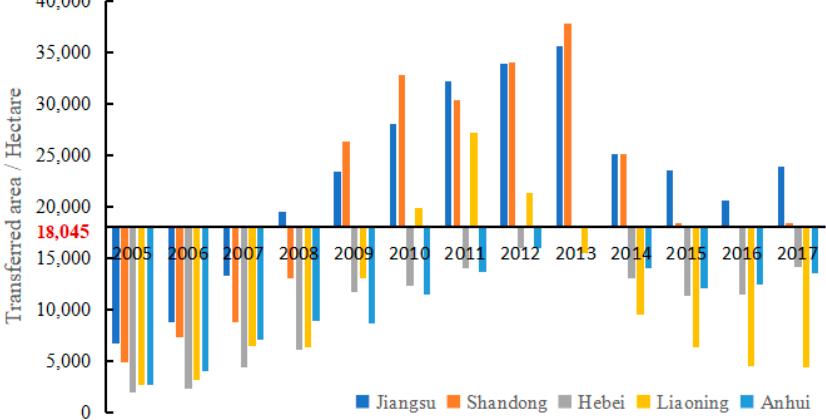
Figure 6. Changes of the land-market supply area in four